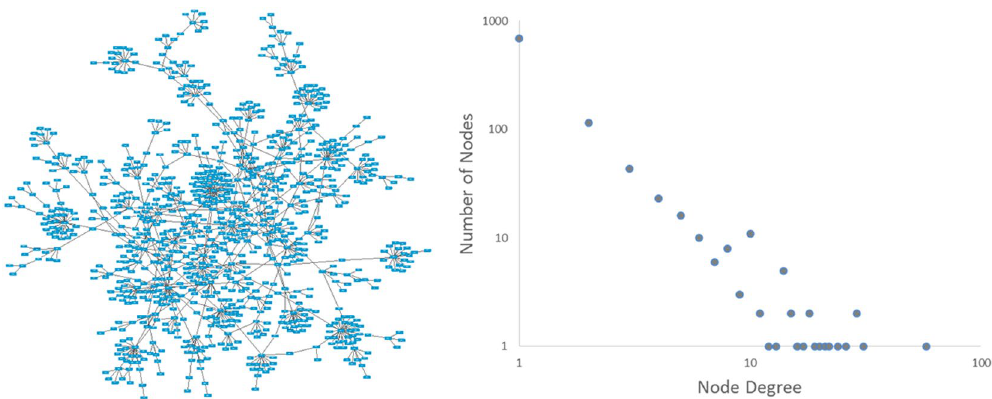
Figure 3. Largest connected component of the sexual contact network (left) and its node degree distribution